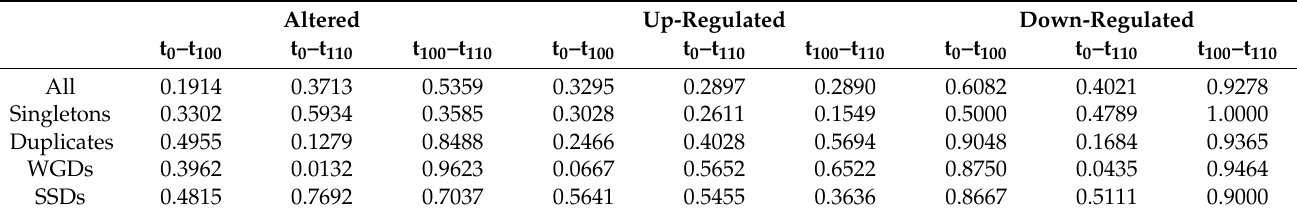
Table 1. Metabolic distances between evolved populations in response to lactic acid/lactate as sole carbon source. Altered Up-Regulated